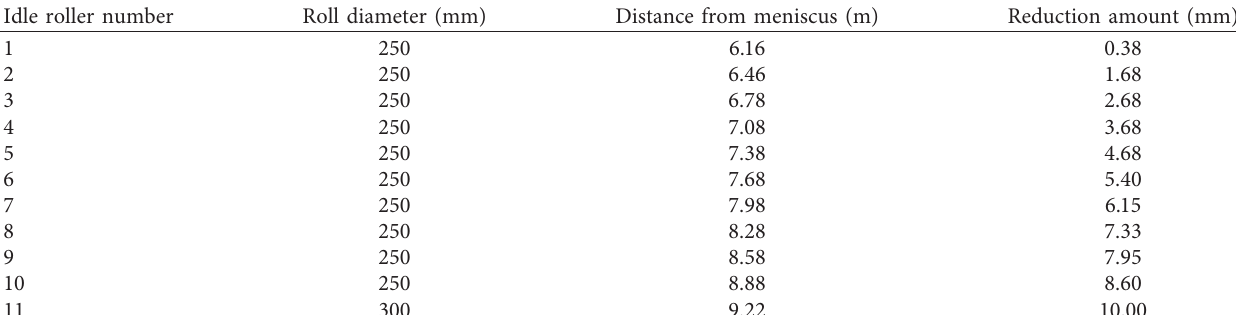
Table 1: The reduction amount of different idle rollers in the reduction zone.